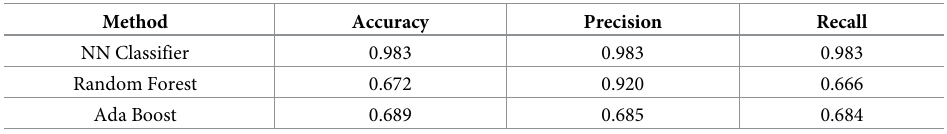
Table 2. Classification results for MNIST